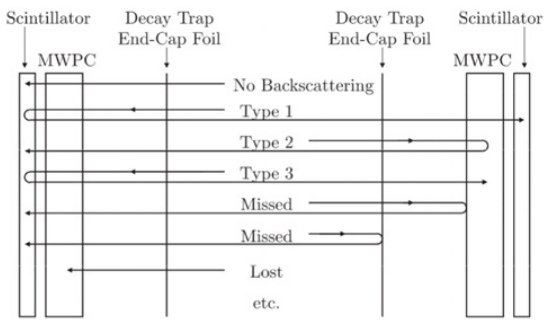
Figure 5. Classification of the different types of events in the experiment.